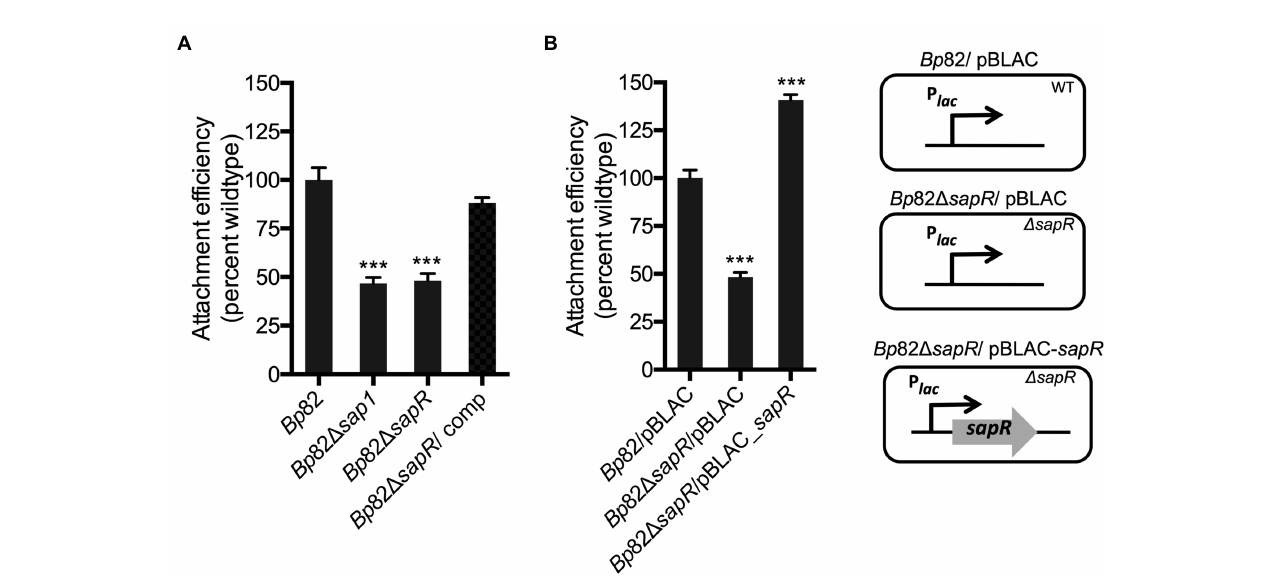
FIGURE 3 SapR is required to activate sap1 for attaching to host cells. Attachment assays on RAW264.7 macrophage monolayers were performed to further validate SapR’s role as an activator for sap1 . (A) The Bp 82 Δ sapR mutant exhibited significant attachment deficiency to RAW264.7 cells, comparing to the Bp82 strain. This deficiency is comparable to the defect in attachment of the Bp 82 Δ sap1 strain. Complement with a single copy of sapR restored the impaired attachment to wildtype level. (B) Bp 82 Δ sapR mutant/pBLAC displayed drastic defect in its attachment ability. Whereas the constitutive expression of sapR in Δ sapR mutant/pBLAC- sapR by inducing the culture with 1 mM IPTG increased bacterial attachment significantly. Data in bar graphs represent means ± s.e.m. and analyzed via unpaired t -test. *** p <